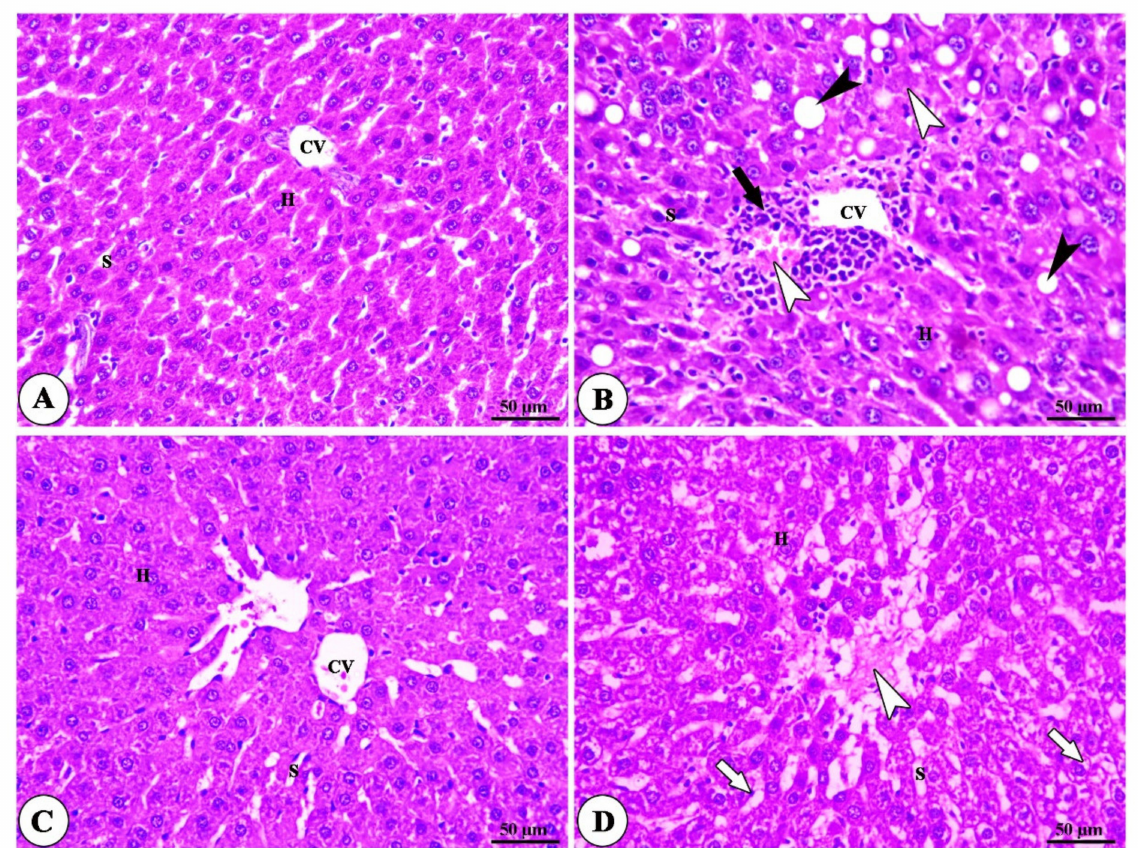
Figure 4. Histomicrograph of liver of normal, hepatocellular carcinoma (HCC), S-methylmethionine sulfonium chloride (MMSC) alone, and HCC + MMSC groups. ( A , C ) show polyhedral-shaped hepatocytes (H) separated by blood sinusoids (S) that appear to have a normal architecture. ( B ) shows the steatohepatic variant of HCC (black arrow head) with necrosis of hepatocytes (white arrow head) and inflammatory cells infiltration (black arrows). ( D ) shows the focal area of hepatic necrosis (white arrow head) and microsteatosis of hepatocytes (white arrows) with dilated and congested in MMSC group and central vein (CV).